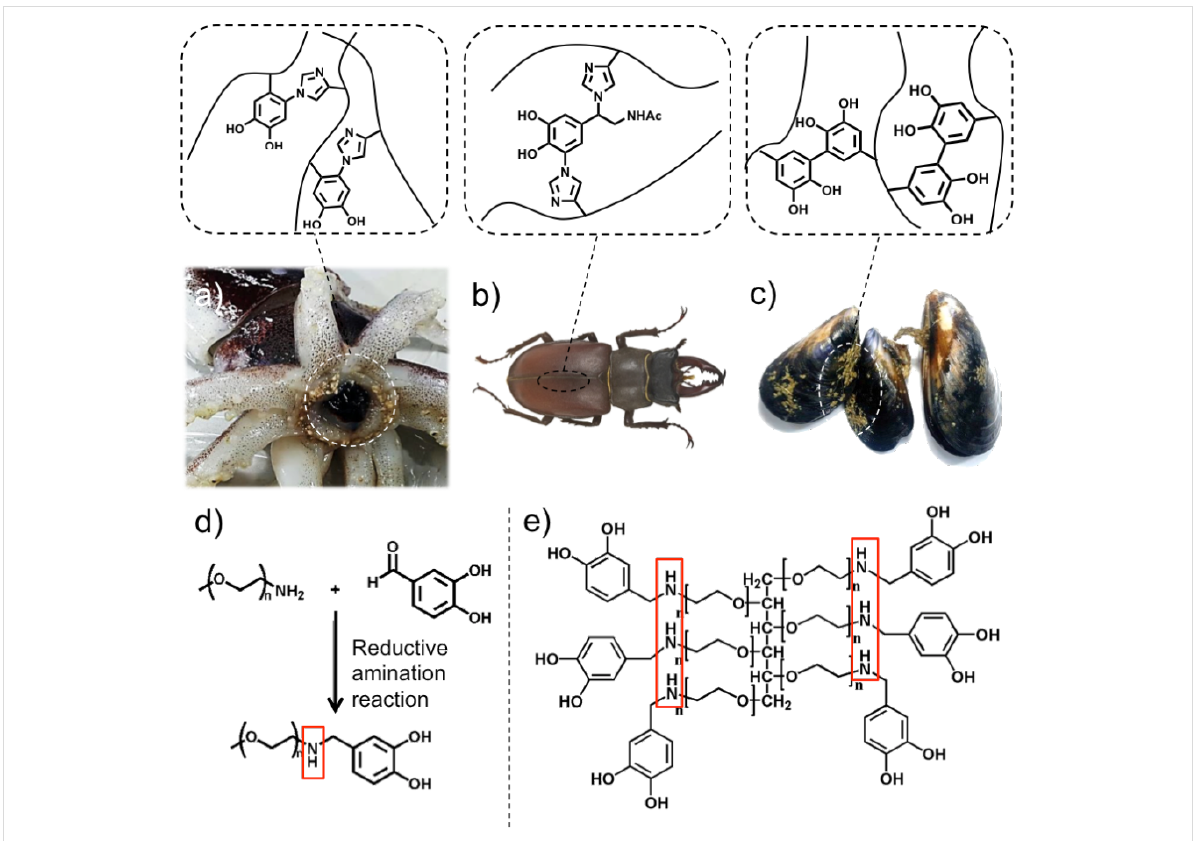
Figure 1: Biomaterials formed by quinone tanning processes found in (a) squid beaks, (b) insect cuticles, and (c) mussel adhesives. Representative chemical reactions were shown for each biomaterials (a,b,c top). Synthetic PEG derivatives that can mimic the natural catecholamine-involved quinone tanning due to the presence of secondary amine : (d) mPEG-NH-catechol for a model reaction, and (e) 6Arm-PEG-NH-catechol for hydrogels.